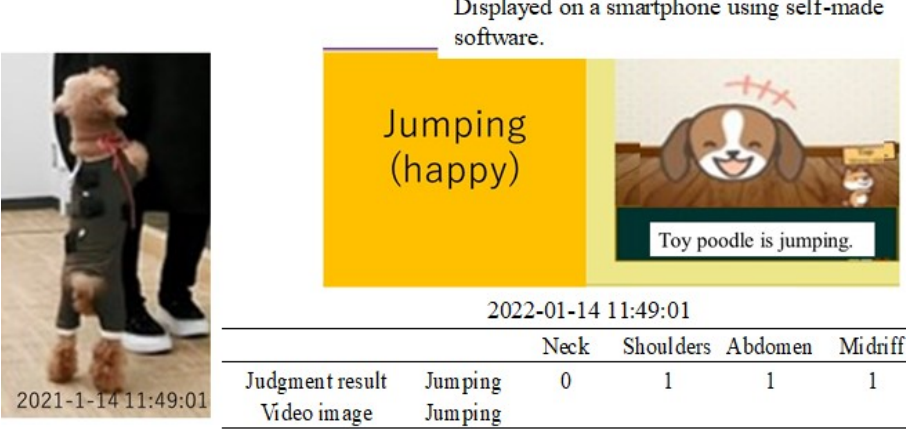
Figure 15. Example of match between the judgment result and the video image.